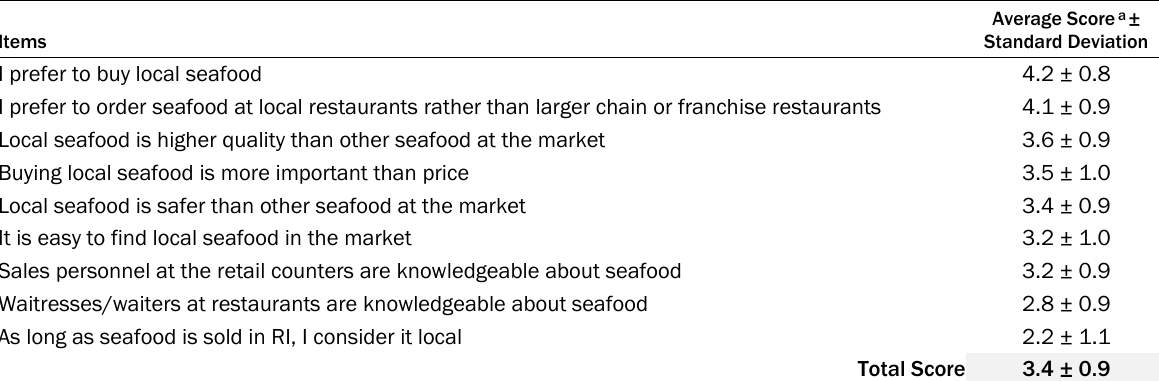
Table 6. Rhode Island Consumer Attitudes Related to Seafood Purchasing and Consumption ( N